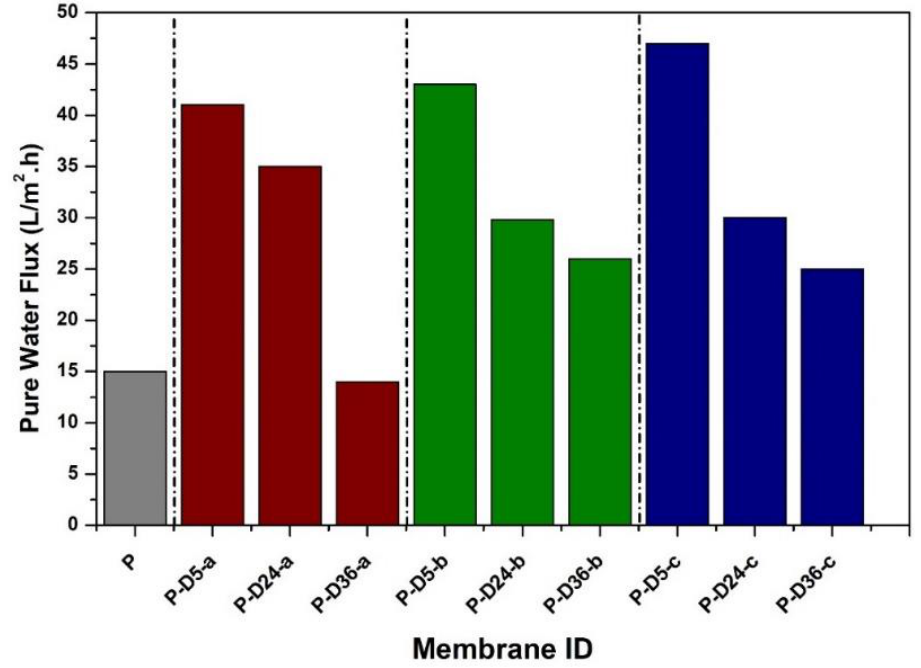
Figure 4. PES membrane pure water flux performance before and after modification with dopamine at various concentrations and dipping times.